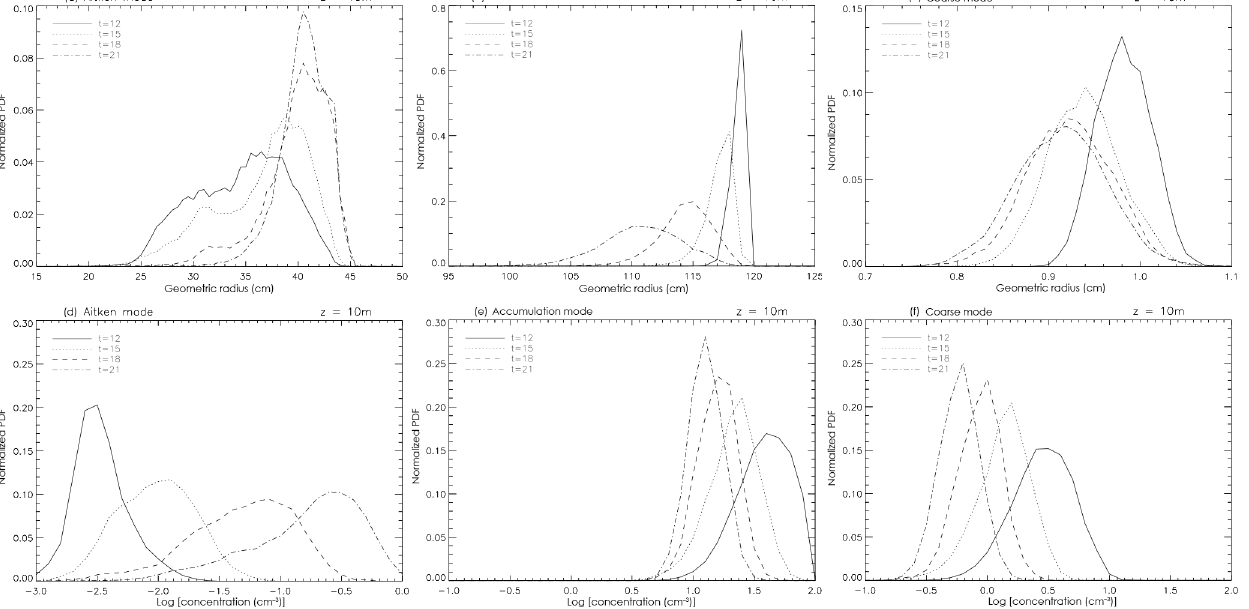
Figure 6. Normalised probability density function (PDF) of the geometric radius (a, b, c) and the logarithm of the concentration (d, e, f) of the surface aerosols from the Aitken (a, d) , accumulation (b, e) , and coarse (c, f) soluble modes obtained at different integration